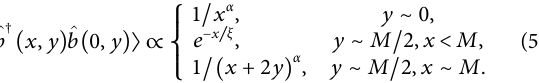
near the ρ = 0 vacuum state. At low density and near the ρ = 0 state, the bosons can be treated as hard-core bosons. For such cases, if the strength J is tuned slightly, the compressibility plot is independent of J when plotted against μ / J . However, for large J = 0.1 U , hard-core